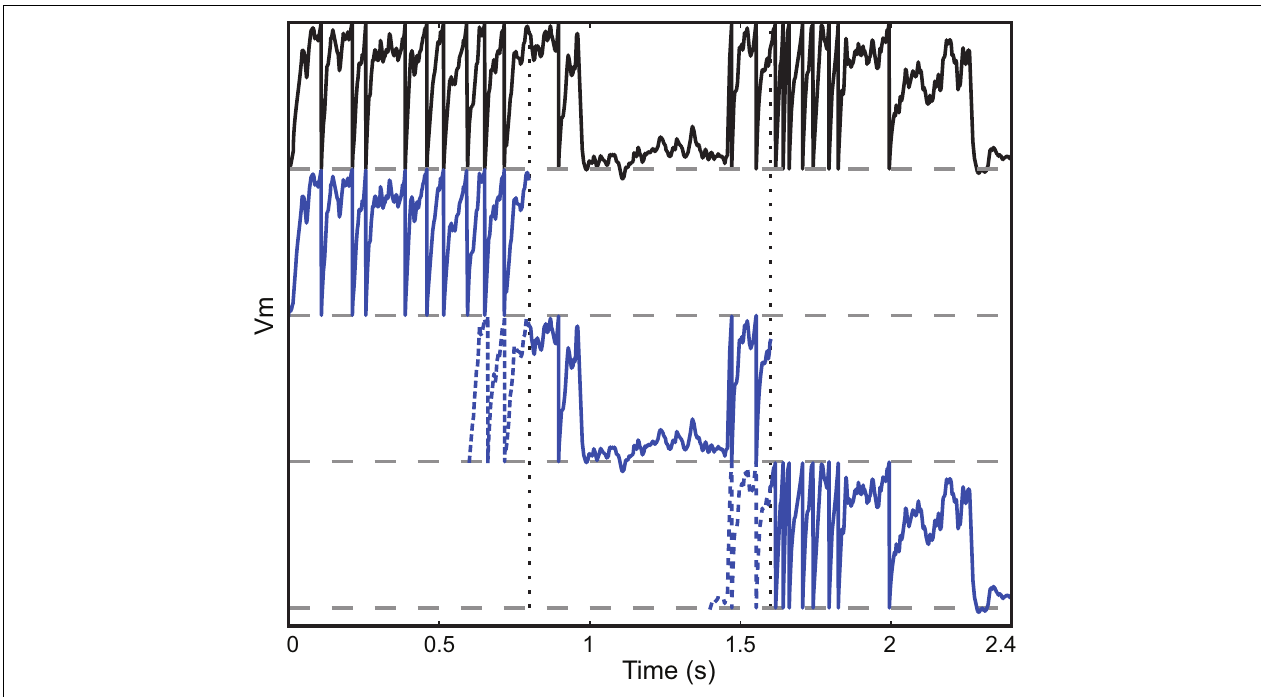
FIGURE 2 | Vectorization over time. A leaky integrate-and fi re neuron receiving a dynamic input current is simulated over 2.4 s (top row, black). The same model is simultaneously simulated in three time slices (blue) with overlapping windows (dashed lines). Vertical dotted lines show the slice boundaries. The model is normalized so that threshold is 1 and reset is 0. The overlap is used to solve the problem of choosing the initial condition and is discarded when the slices are